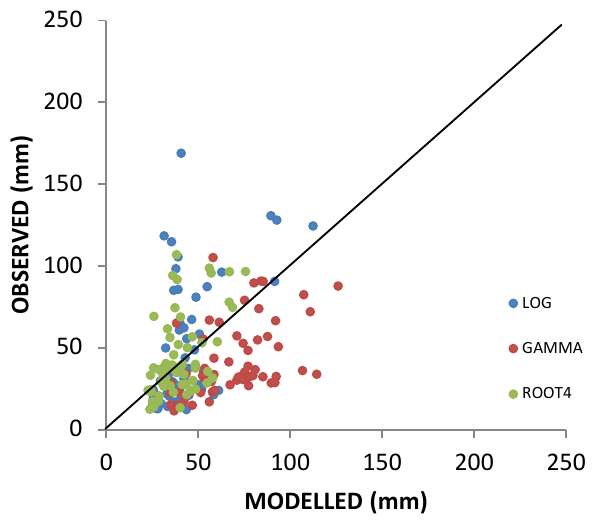
Fig. 13. Observed and modelled 10yr return period daily rainfall totals for Network A. Note comparable statistics were not derived for Network B because of insufficient data.